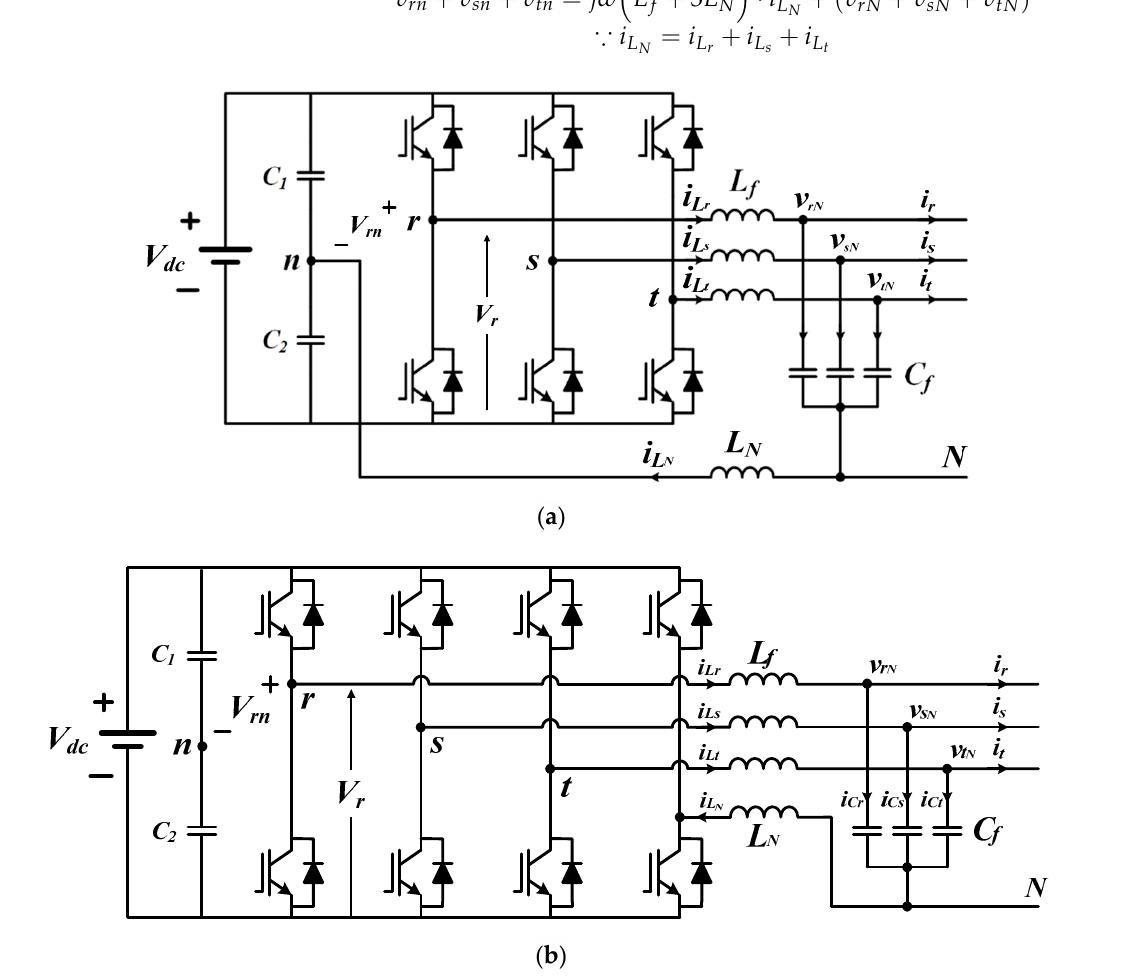
Figure 4. Circuit configuration of a 3-phase 4-wire inverters: ( a ) 3-leg inverter employing split-dc-link capacitor; ( b ) 4-leg inverter.